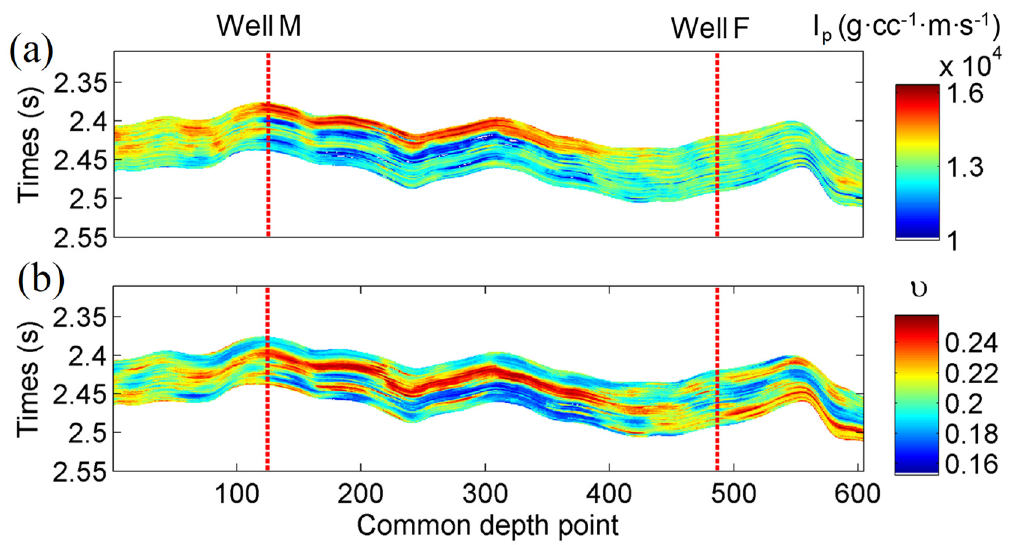
Figure 15. 2-D seismic profiles of P-wave impedance ( a ) and Poisson’s ratio ( b ).